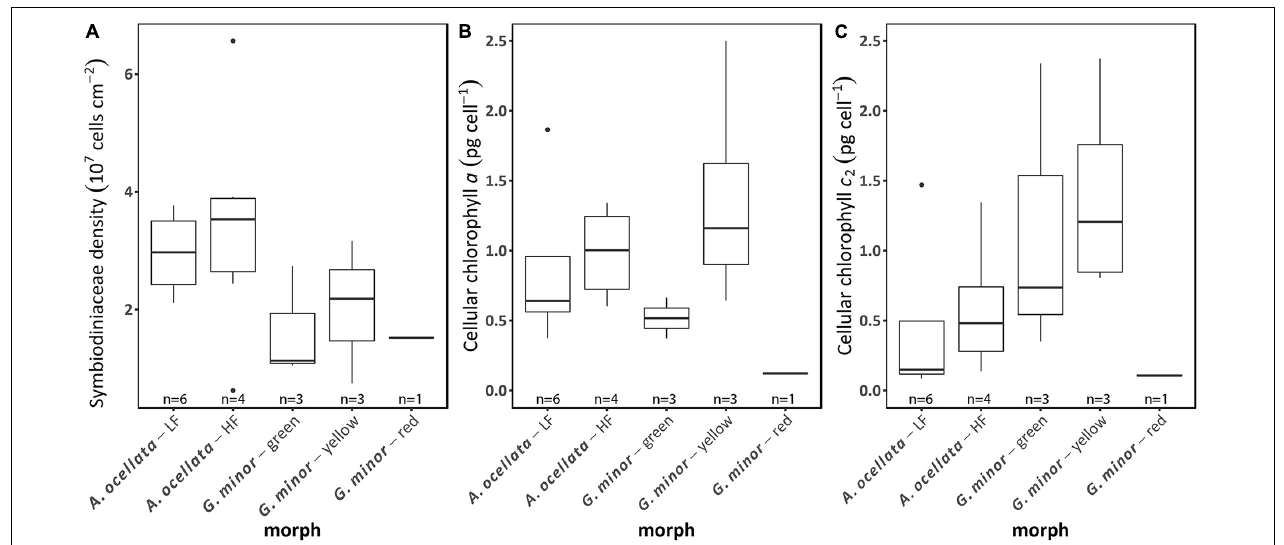
FIGURE 5 | Photobiology of fluorescence morphs of the mesophotic corals Alveopora ocellata and Goniopora minor . Areal Symbiodiniaceae density (A) , cellular chlorophyll a (B) , and cellular chlorophyll c 2 (C) of low fluorescence (LF) and high fluorescence (HF) morphs of A. ocellata and green, yellow, and red fluorescence morphs of G. minor . Boxes represent the upper and lower quartile, center lines represent medians, and whiskers extend to data measurements that are less than 1.5*IQR away from first/third quartile. Outliers are represented by dots. Sample size ( n ) is indicated below each